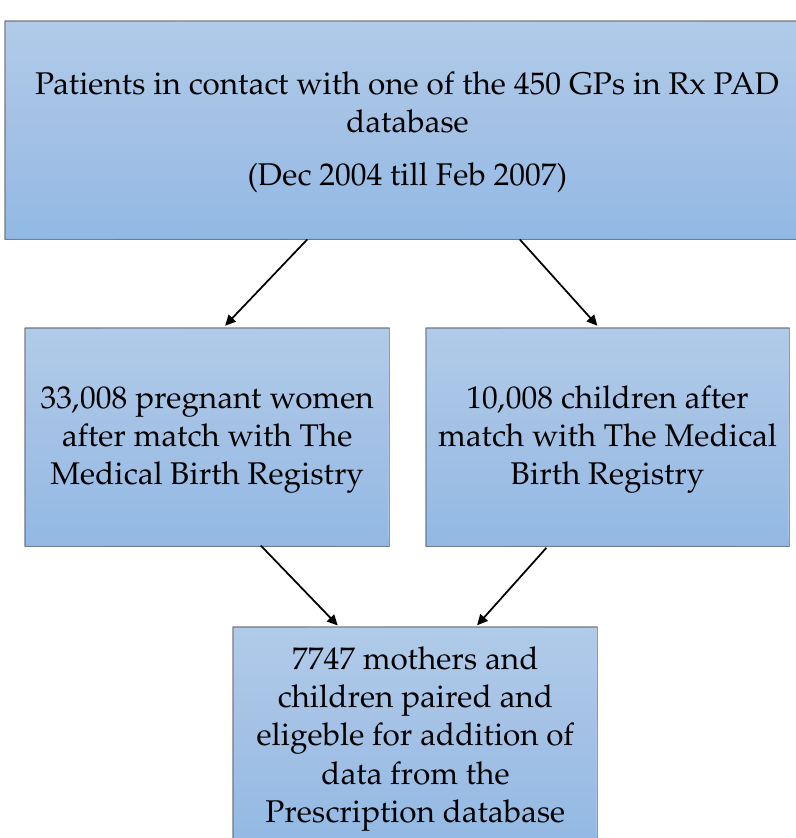
Figure 3. Selection of patients. (GP = general practitioner). Trimesters are calculated by length of pregnancy according to Norwegian standards published previously [1,40]. Preterm birth is defined as birth before 37 gestational weeks, according to WHO and Norwegian standards. Mother’s smoking habits are based on data from the Medical Birth Registry of Norway, as are gender of the child and mother’s age. Antibiotics are defined as all ATC code J01 prescriptions. Antiasthmatics are defined as all ATC code R03